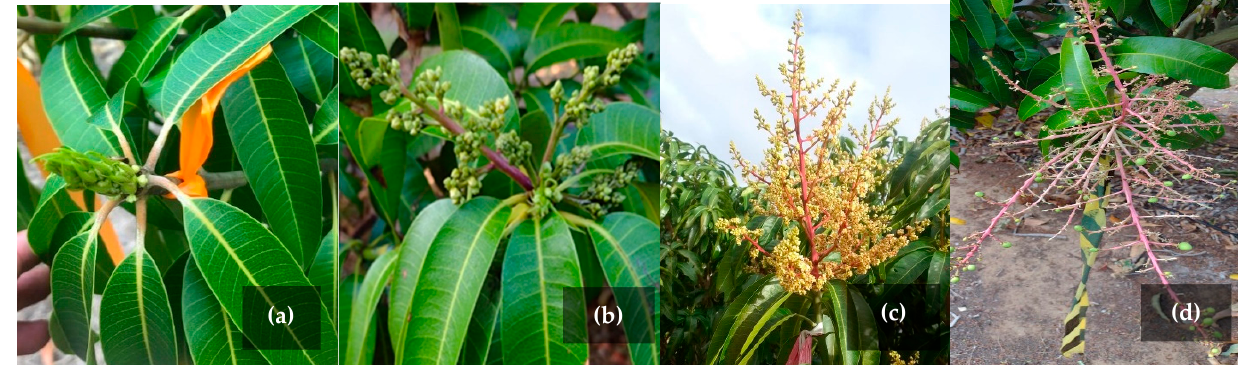
Figure 1. Stages of development of flowering illustrated by images of cultivar Calypso: ( a ) asparagus stage, ( b ) elongation phase, ( c ) Christmas tree stage (two thirds of flowers on panicle open), ( d ) fruit set stage.